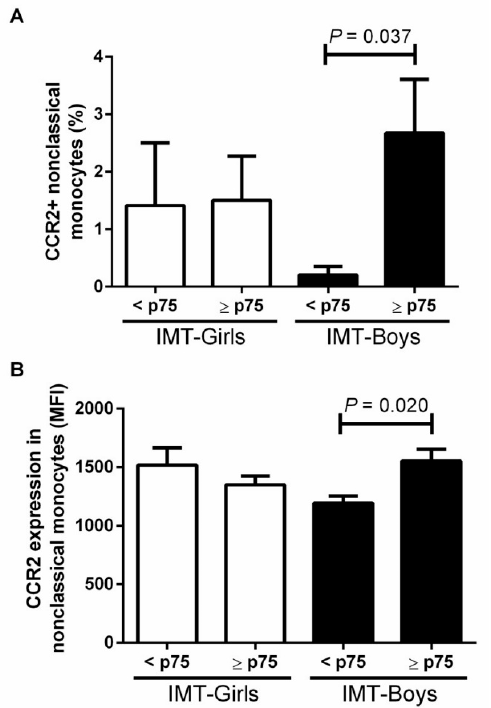
Figure 4. Evaluation of ( A ) the proportion of CCR2 in nonclassical monocytes and intima media thickness (IMT) and ( B ) expression of CCR2 in nonclassical monocytes and intima media thickness (IMT) by sex. We considered a high-risk IMT ≥ p75 and compared differences by the student T-test, considering a p value < 0.05 as significant.